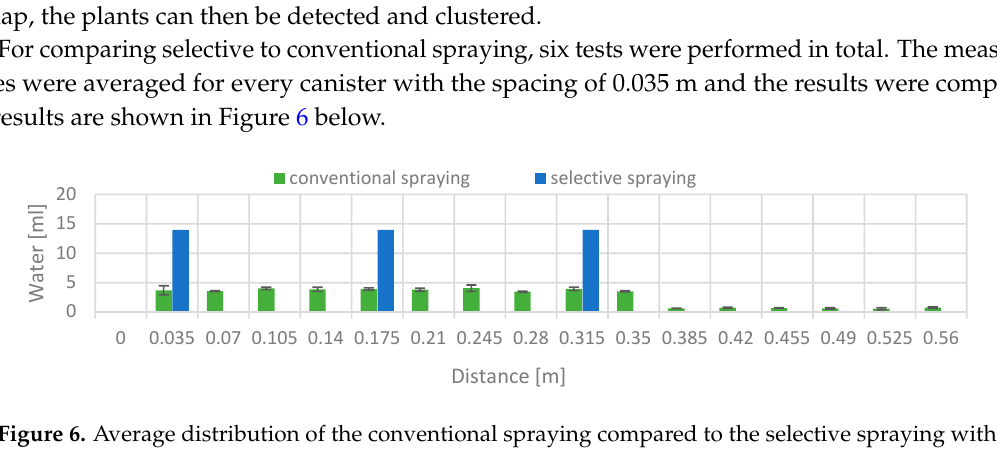
Figure 6. Average distribution of the conventional spraying compared to the selective spraying with two standard deviations.